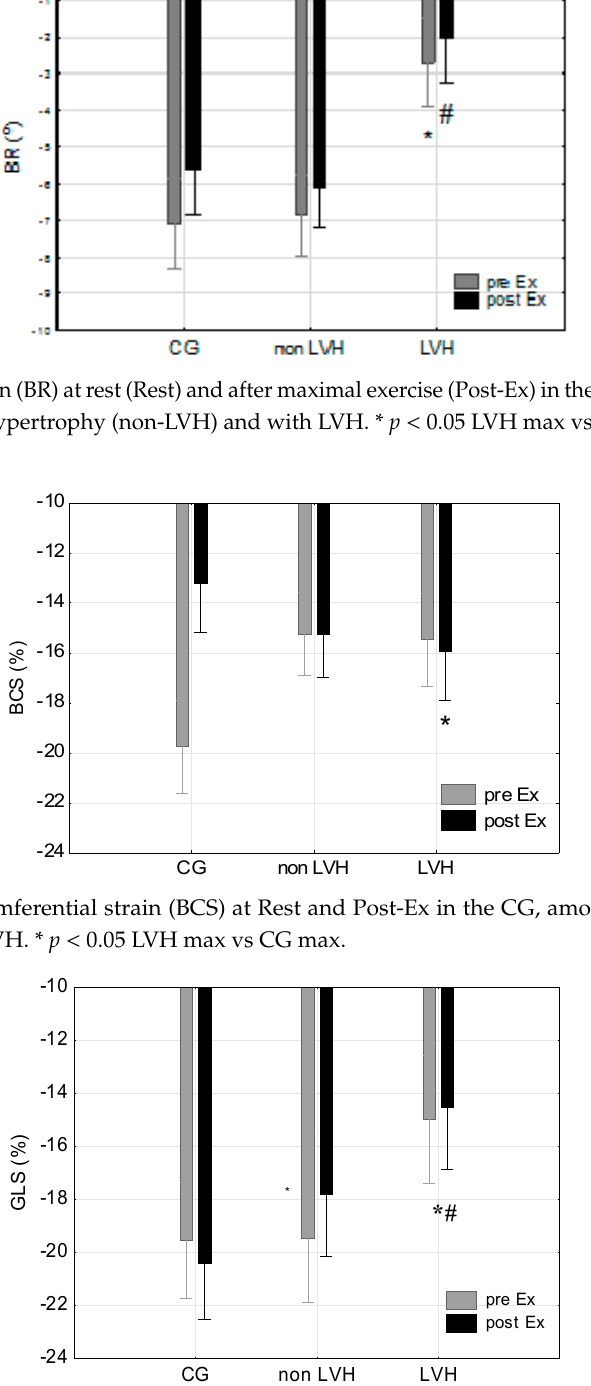
Figure 4. Global longitudinal strain (GLS) at Rest and Post-Ex in the CG, among cyclists without ventricular hypertrophy (non-LVH) and with LVH. * p < 0.05 LVH vs CG; # p < 0.05 LVH vs non- LVH.